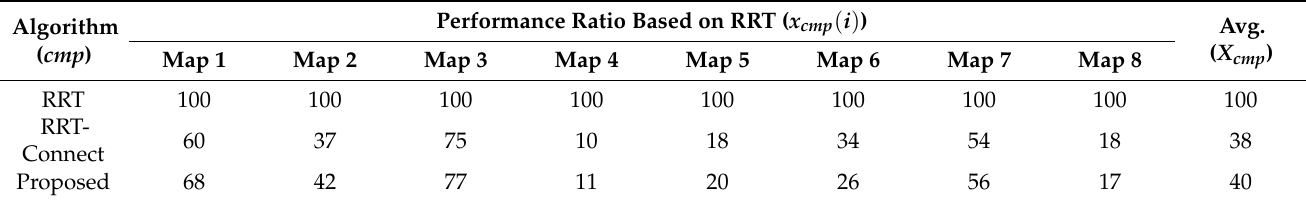
Table 10. Experimental results in total for the average number of samples (for first path finding)